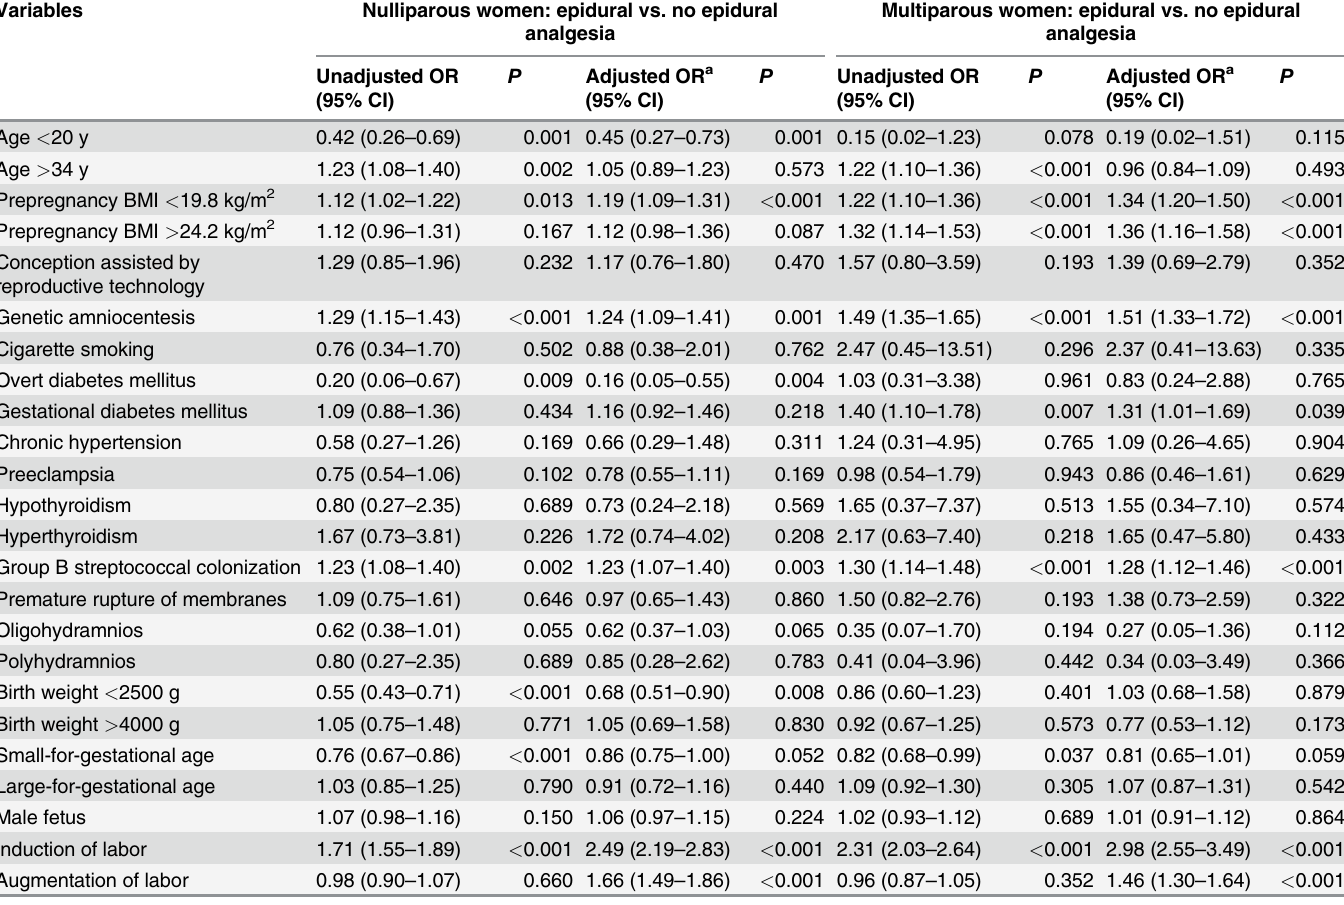
Table 4. Factors associated with intrapartum use of epidural